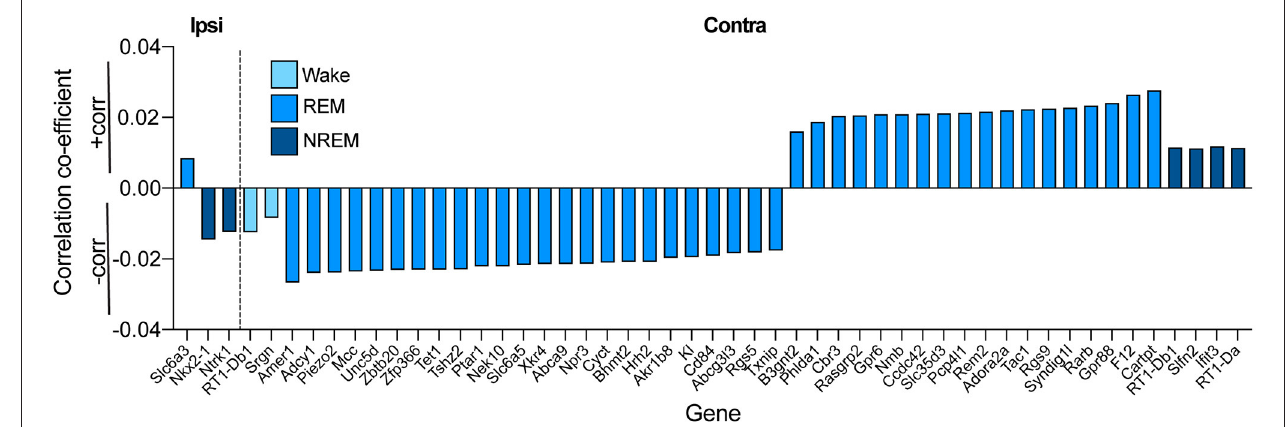
FIGURE 8 | Association of time spent in sleep states vs. gene expression on the ipsilateral and contralateral sides of injury in both PBBI and sham cortex (conditions pooled together and injury was controlled for in statistical model) identified differentially expressed genes (adj. p < 0.05) associated with the three vigilance states examined. Directionality of the correlation between transcription and sleep are indicated as + corr ( > 0; positive correlation) or –corr ( < 0; negative